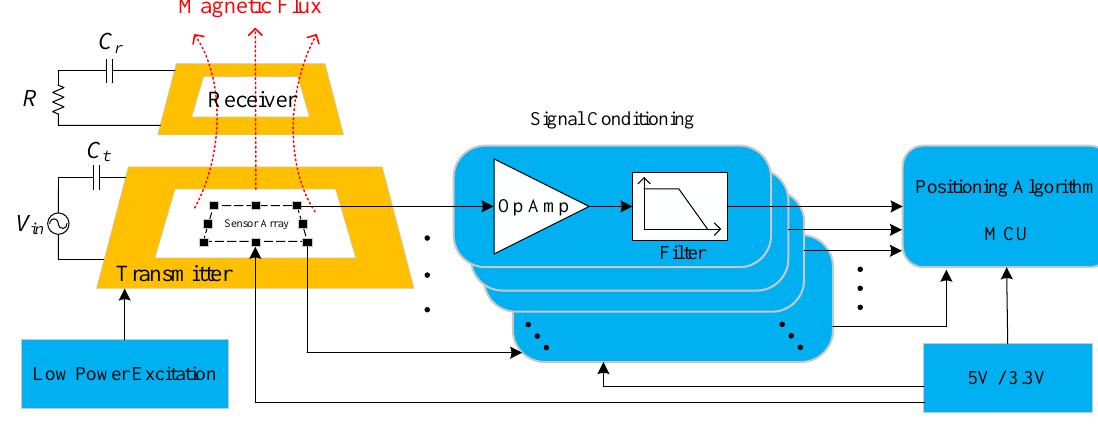
Figure 2. Structure of the coil positioning system.